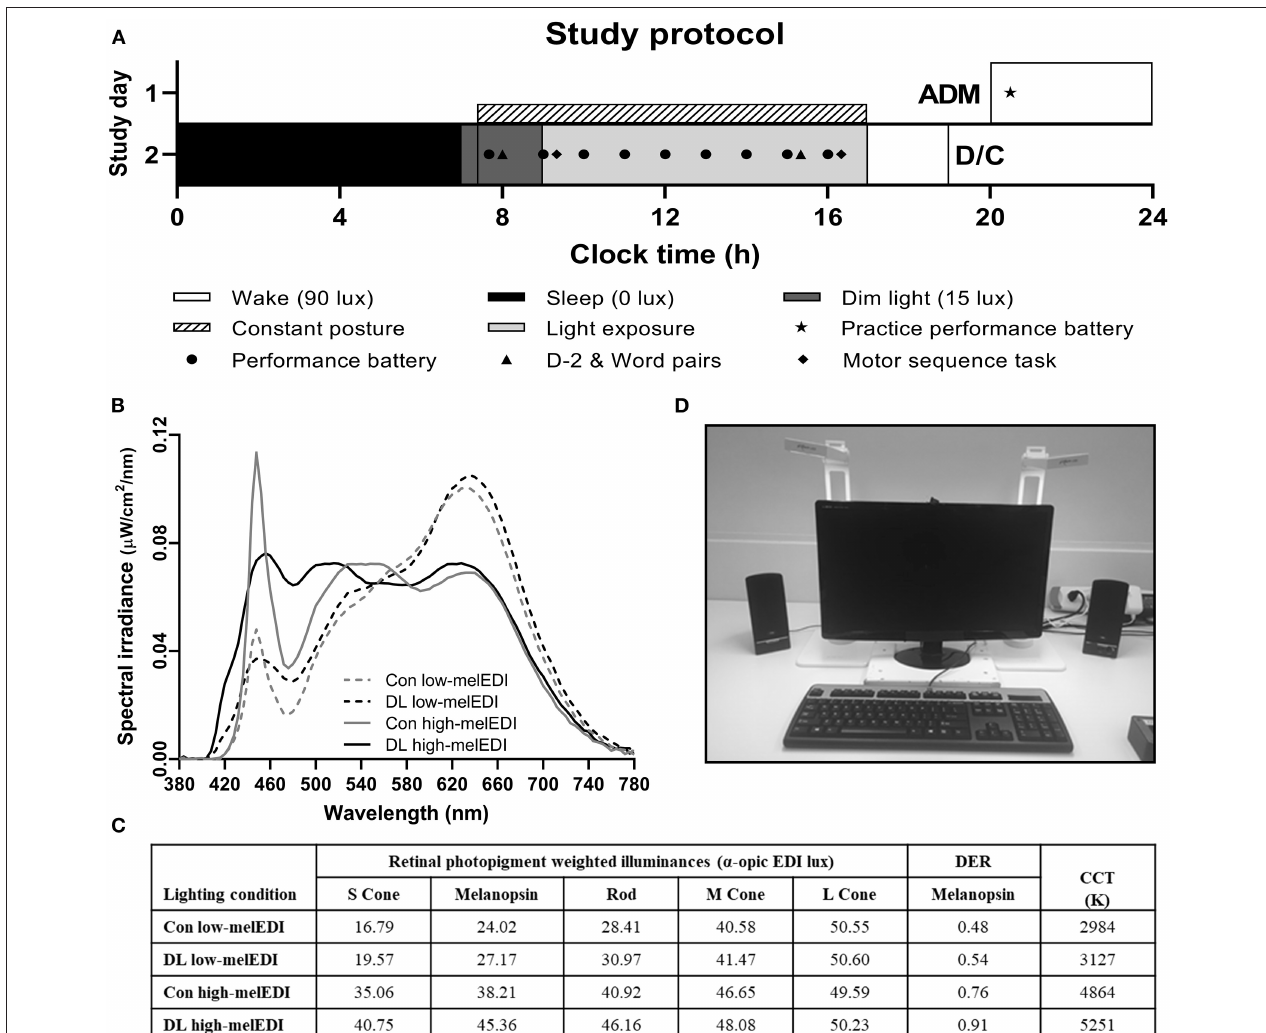
FIGURE 1 | Study protocol and light source spectral characteristics and experimental configuration. The study protocol (A) consisted of one night in the laboratory where participants were admitted in the evening and maintained their pre-admit sleep-wake cycle including a 7-h sleep opportunity. On Day 2, participants underwent an 8-h light exposure where they were exposed to 50 lux of experimental light with differing spectra (B) 3000K or 5000K of standard (conventional) or full-spectrum ∼ (daylight-like) LED light. During the light exposure, two lamps were configured on either side of the testing station monitor at which participants maintained a constant posture (C) . α -opic EDI and DER values for each light source (D) were derived from the CIE S 026:2018 Toolbox V1.049. ADM, admission; CCT, correlated color temperature; Con, Conventional; D/C, discharge; DER, daylight (D65) efficacy ratio; DL, Daylight-like; EDI, equivalent daylight (D65)